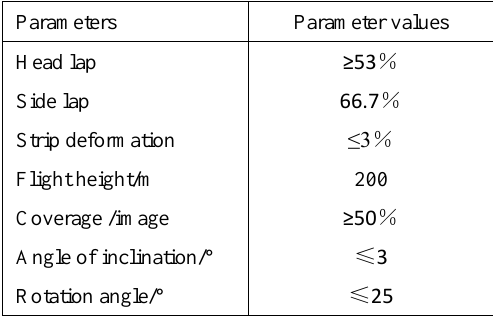
Table 1 . UAV flight parameters